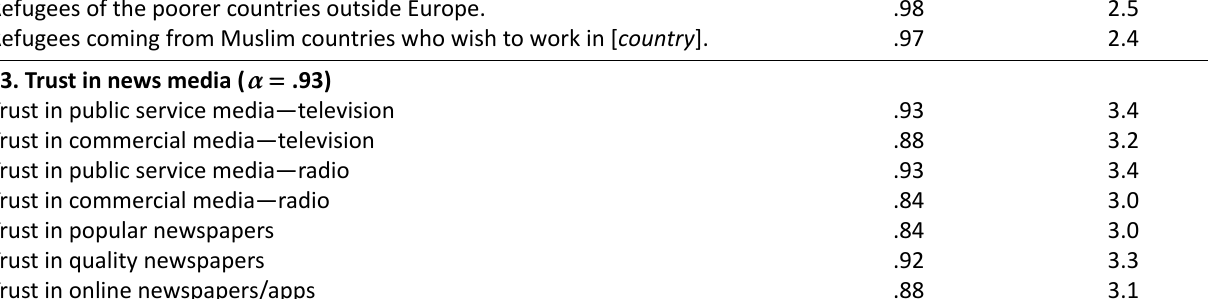
Table 2. Latent construct measurement overview: confirmatory factor analysis and reliability. Item description Standardized loading Mean item score F1. Attitudes on immigrants ( 𝛼𝛼𝛼 === .94) Immigrants of same race or ethnicity as most of [ country ]’s population. .92 Immigrants of a different race or ethnicity than most of [ country ]’s population. .97 Immigrants of the richer countries in Europe. Immigrants of the poorer countries in Europe. Immigrants of the richer countries outside Europe. Immigrants of the poorer countries outside Europe. Immigrants coming from Muslim countries who wish to work in [ country ]. F2. Attitudes on refugees ( 𝛼𝛼𝛼 === .96) Refugees of the same race or ethnicity as most of [country]’s population. Refugees of a different race or ethnicity than most of [country]’s population. Refugees of the richer countries in Europe. Refugees of the poorer countries in Europe. Refugees of the richer countries outside Europe. Refugees of the poorer countries outside Europe. Refugees coming from Muslim countries who wish to work in [ country ]. F3. Trust in news media ( 𝛼𝛼𝛼 ===